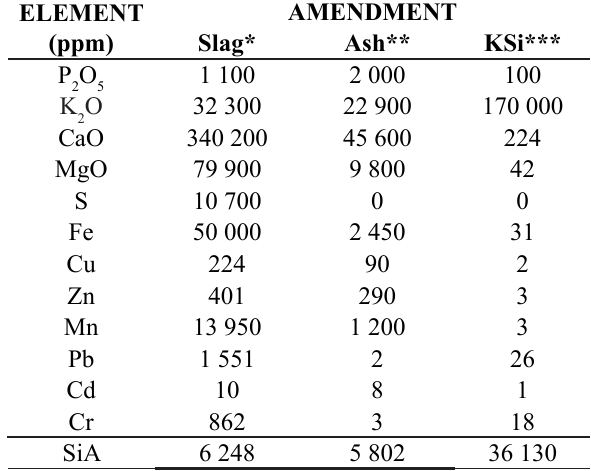
Table 2. Complete chemical profile of the three silicon sources (total content) and availability of silicon